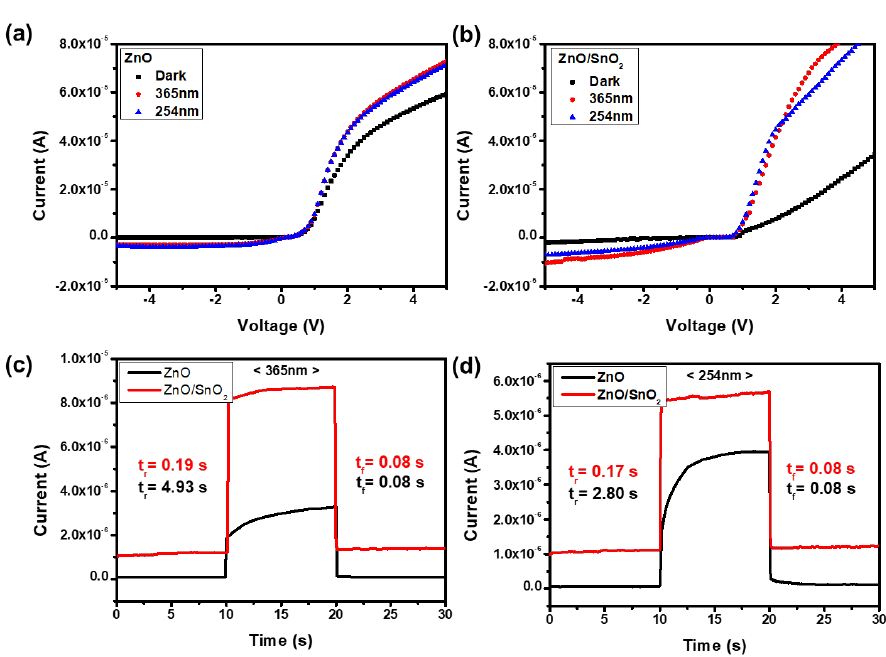
Figure 5. The I–V characteristics of ( a ) ZnO and ( b ) ZnO/SnO 2 PDs under dark, 365 nm, and 254 nm UV light conditions. Time-domain photoresponse of ZnO and ZnO/SnO 2 PDs under ( c ) 365 nm UV light and ( d ) 254 nm UV light at a fixed bias condition of − 5 V.